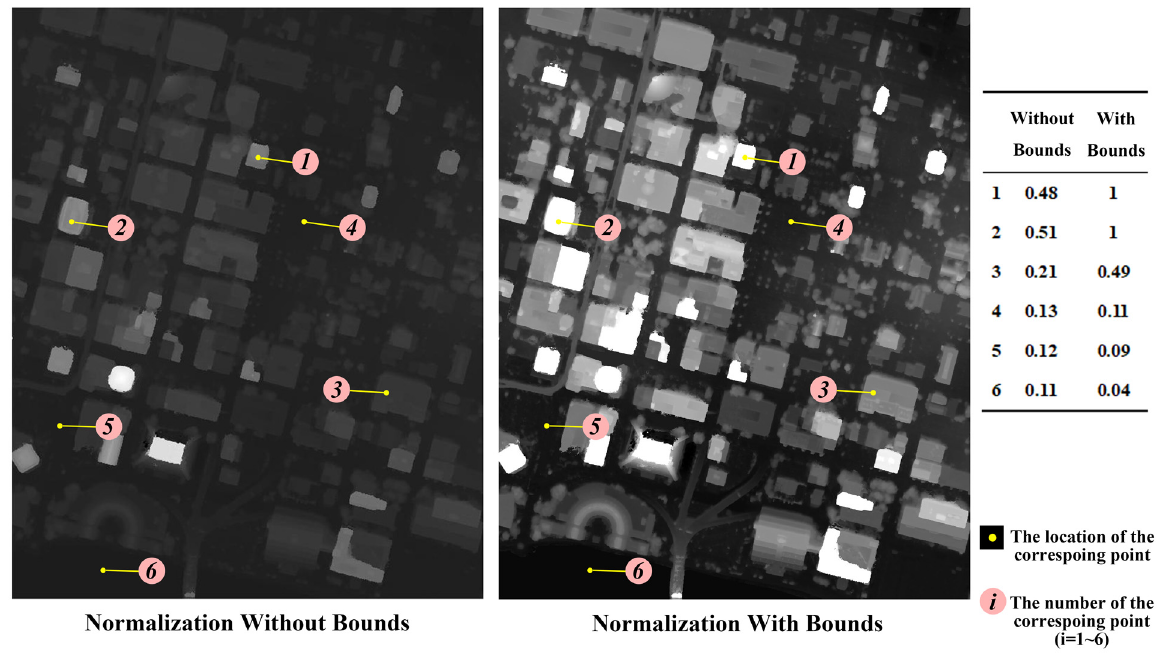
Figure 5. Normalization result with/without bounds in a region of Jacksonville, USA.